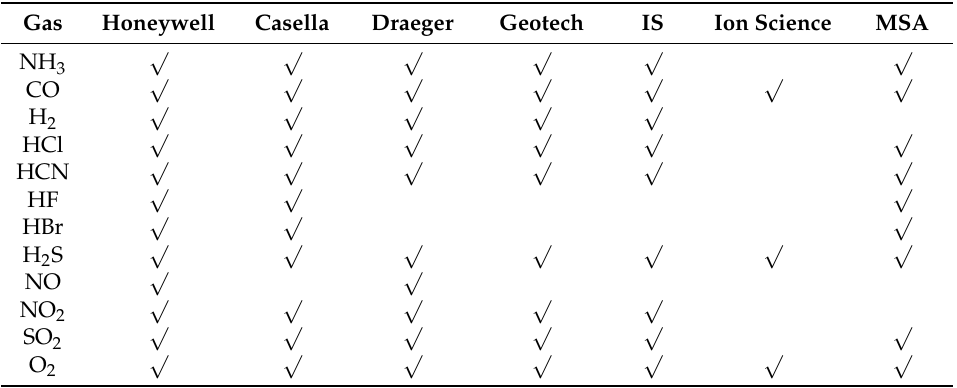
Table 5. Availability of electrochemical cells for the detection of toxics 1